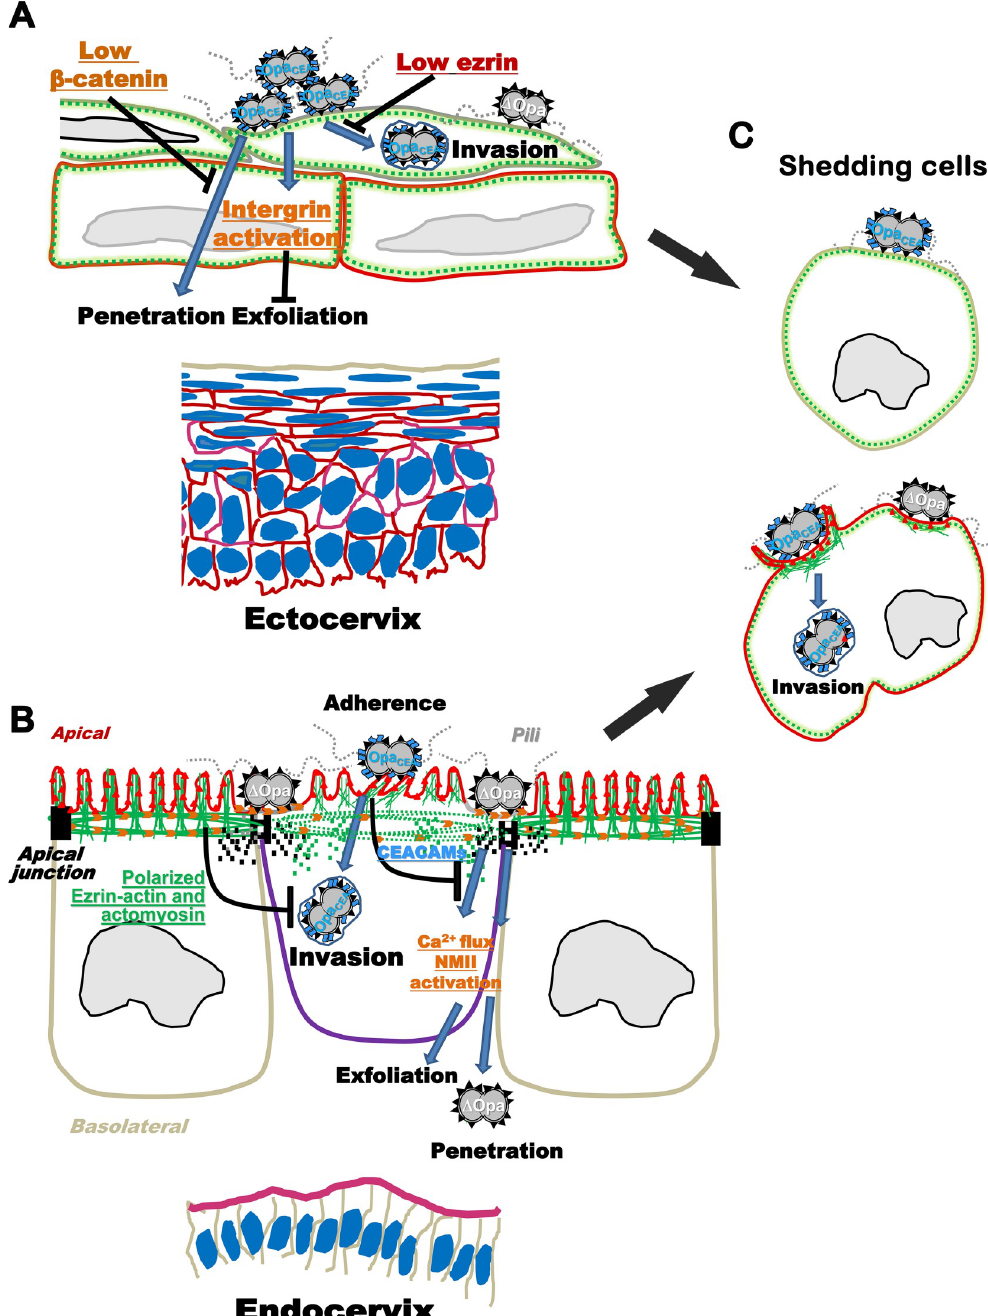
Fig 9. A working model for GC infection in the human cervix. (A) GC infection in the ectocervical epithelium. Low expression levels of β -catenin and ezrin in the luminal layer of cervical epithelial cells (A lack of red color at the cell periphery indicates the low expression level of ezrin) potentially inhibit GC-induced actin (green dashed lines at the cell periphery) reorganization. GC also activate β 1 integrin in ectocervical epithelial cells, which suppresses epithelial exfoliation and enhances GC adherence. (B) GC infection in the endocervical epithelium. GC interactions with the apical surface of columnar cervical epithelial cells with ezrin-actin-supported dense microvilli (ezrin, red triangles; and actin, green lines) activate NMII (orange arrows) at GC adherent sites in a Ca 2+ -dependent manner. The activation and reorganization of NMII induce the disassembly of both ezrin-actin networks underneath GC microcolonies and perijunctional actomyosin rings, which leads to microvilli modification and apical junction disassembly, facilitating GC transmigration across the epithelium and causing epithelial shedding. (C) GC infection in ezrin-expressing (red cell border) squamous epithelial